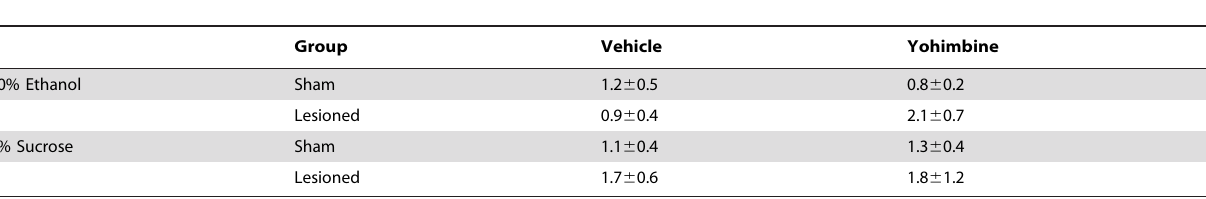
Table 3. Inactive lever presses following vehicle or yohimbine administration during reinstatement of ethanol or sucrose seeking.